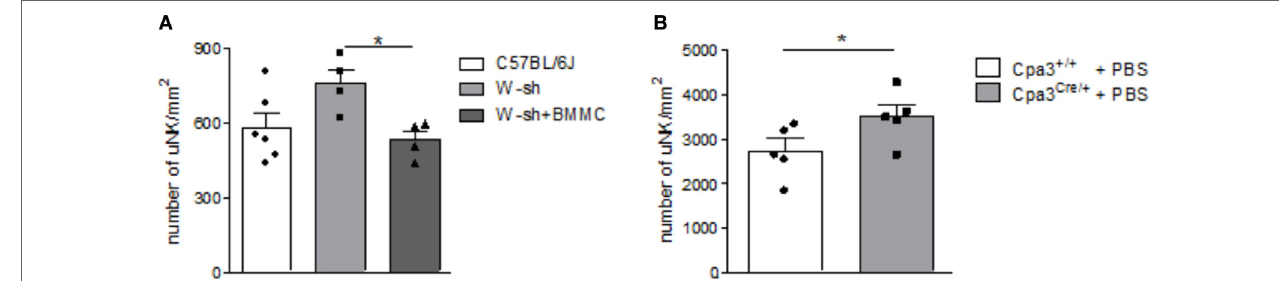
FigUre 1 | Mast cell (MC)-deficient mice show increased numbers of uterine natural killer cells (uNKs) in contrast to wild type (WT). Bone marrow-derived MCs (BMMC) reconstitution restored this phenotype. Numbers of uNKs cells per 1 mm 2 were quantified in Dolichos biflorus agglutinin lectin-stained 5 µm paraffin cross sections of implantations of WT C57BL/6J ( n = 6), MC-deficient W-sh ( n = 4), or BMMC-reconstituted W-sh ( n = 4) mice (a) as well as in Cpa3 + / + control mice ( n = 5) vs. MC-deficient Cpa3 Cre/ + ( n = 5) mice (B) at gd10. Results are presented as means with SEM. Also individual values are shown by dots, squares and triangles. Statistical differences were obtained using Mann–Whitney U -test (* P < 0.05). MCs, mast cells; NKs, natural killer cells; u, uterine; WT, wild type; BMMC, bone marrow-derived mast cells; W-sh , C57BL/6J-Kit W-sh/W-sh